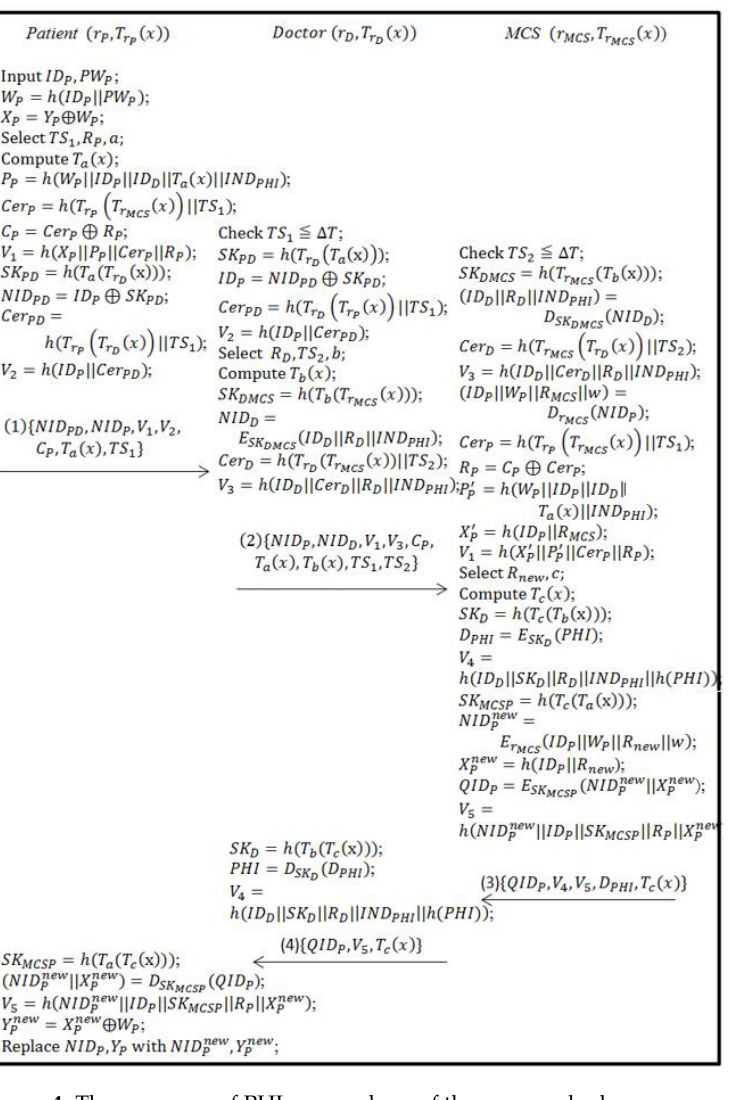
Figure 4. The processes of PHI access phase of the proposed scheme.